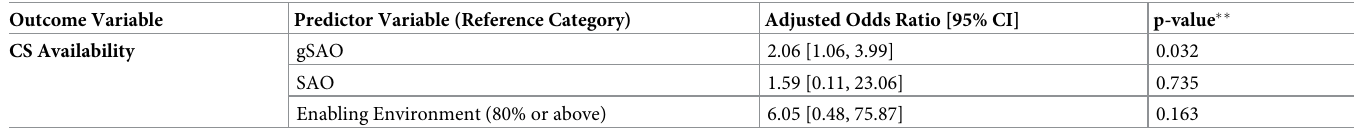
Table 2. Multivariate associations predicting access to CS. Outcome